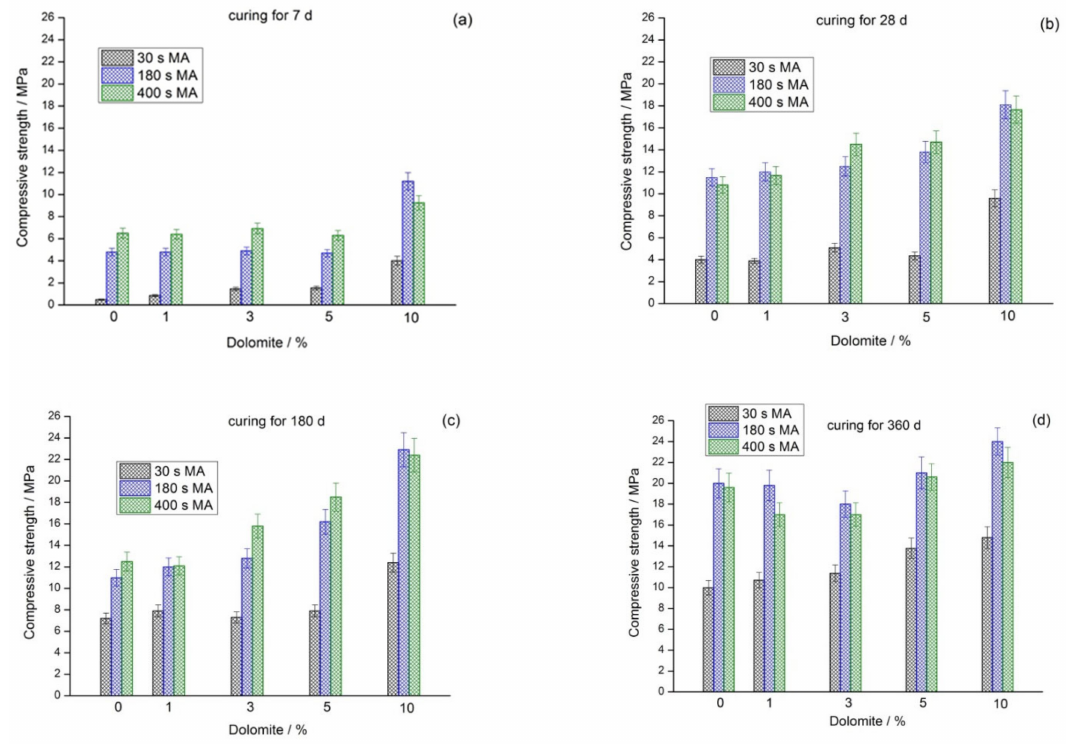
Figure 3. Effect of dolomite content and MA time on the compressive strength of geopolymers cured for 7 ( a ), 28 ( b ), 180 ( c ), and 360 ( d )